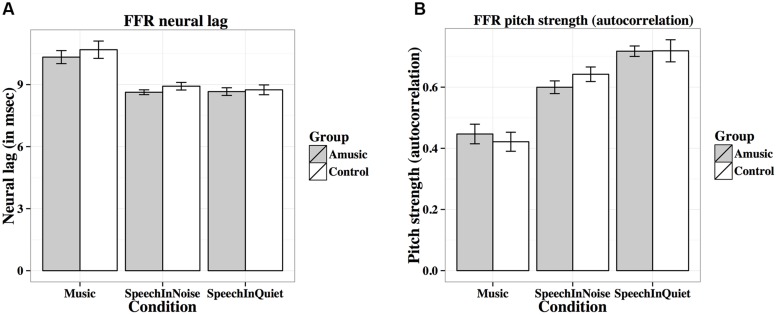
Frequency-following response (FFR) neural lags (A; in ms) and pitch strengths (B; autocorrelations) of amusics and controls under the three experimental conditions (music, speech-in-noise, speech-in-quiet).